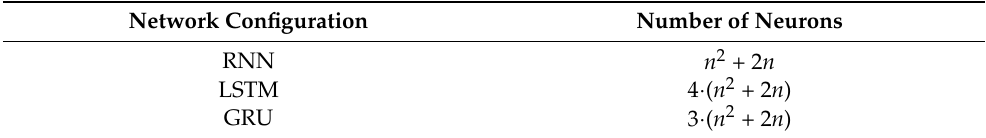
Table 2. Number of neurons for different configurations.